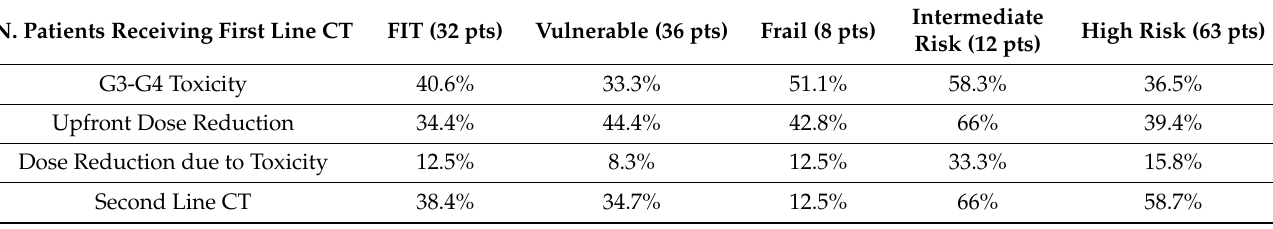
Table 4. Rates of severe toxicities, upfront dose reduction and access to second line treatment according to CGA category and onco-MPI risk groups (% of pts).